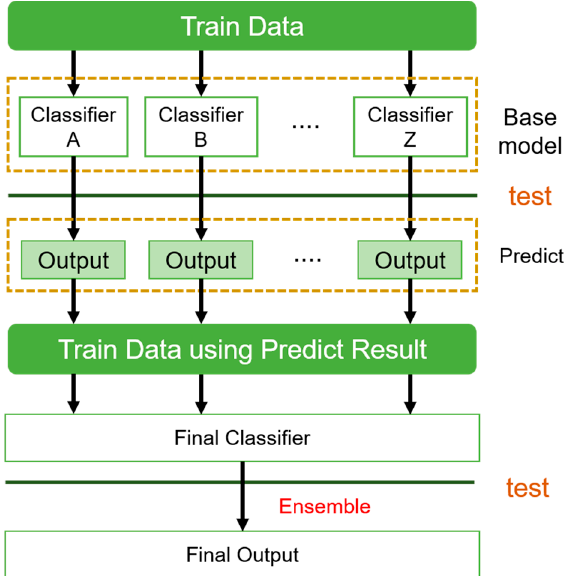
Figure 3. Stacking method using the performance of classification prediction result.